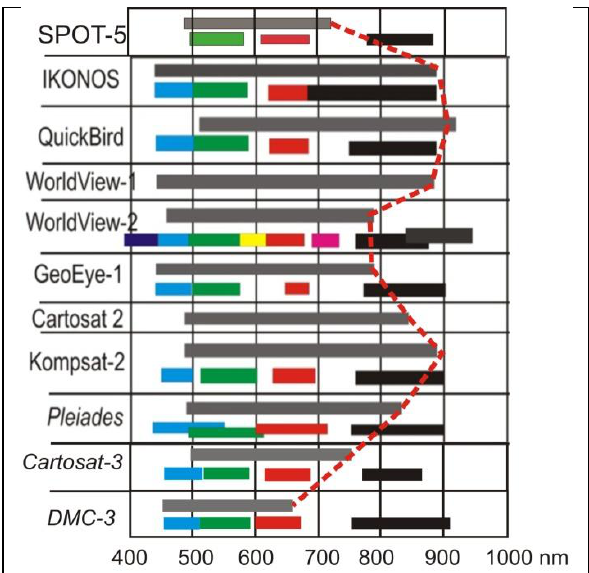
Fig. 3 : discrepancies at GCPs in the three models